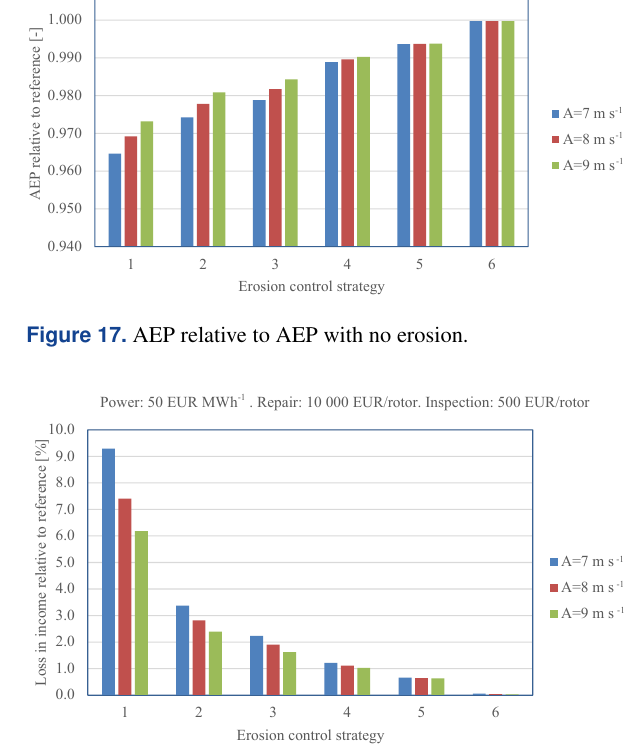
Figure 18. Loss of income due to erosion, inspection and repair. Energy: 50EURMWh − 1 . Repair: 10000EURrotor − 1 . Inspection: 500EURrotor − 1